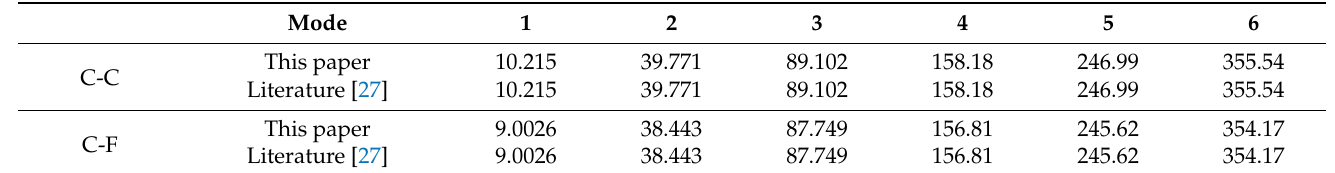
Table 1. Comparison of natural frequencies for Reddy circular plates ( Ω = 0, k → ∞ , s = 0